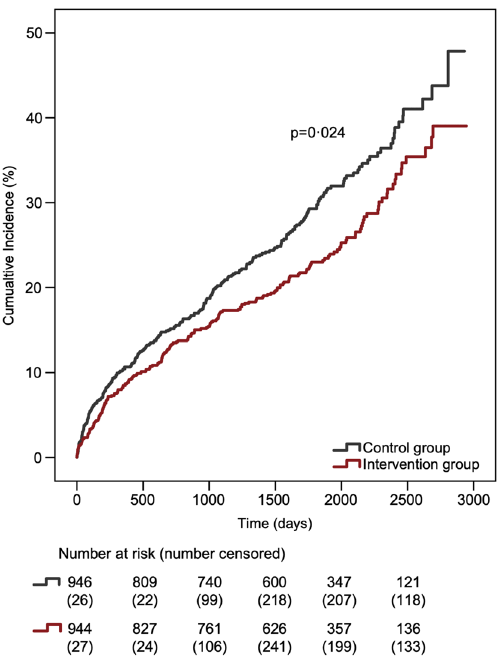
Figure 2. Cumulative incidence of the primary outcome. The primary outcome included non-fatal stroke, non- fatal myocardial infarction, cardiac revascularisation, and cardiovascular death.